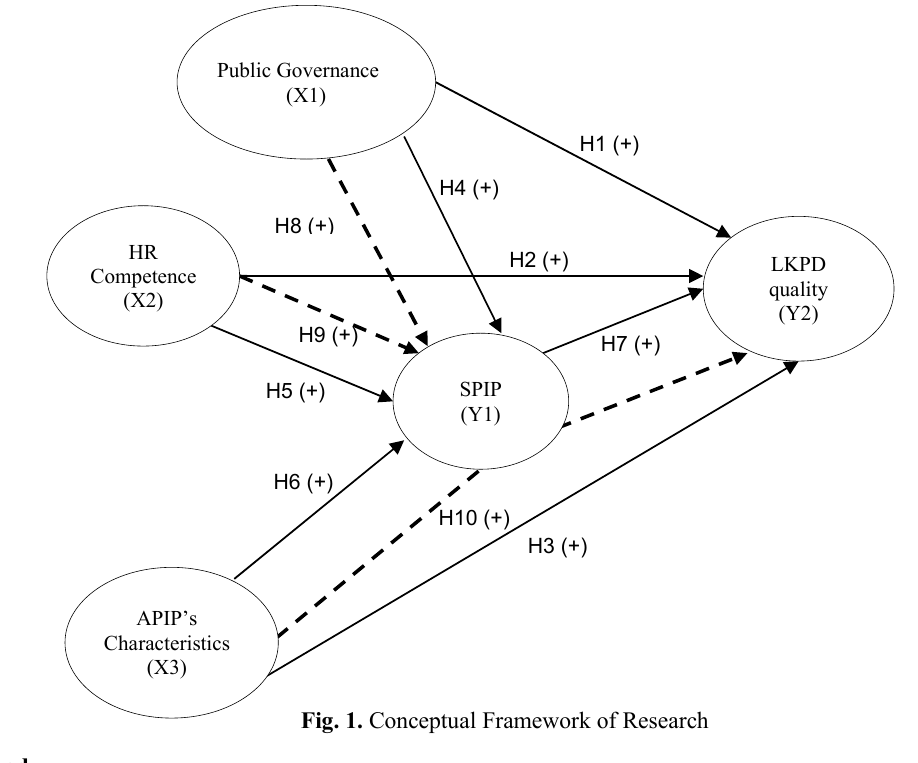
Fig. 1. Conceptual Framework of